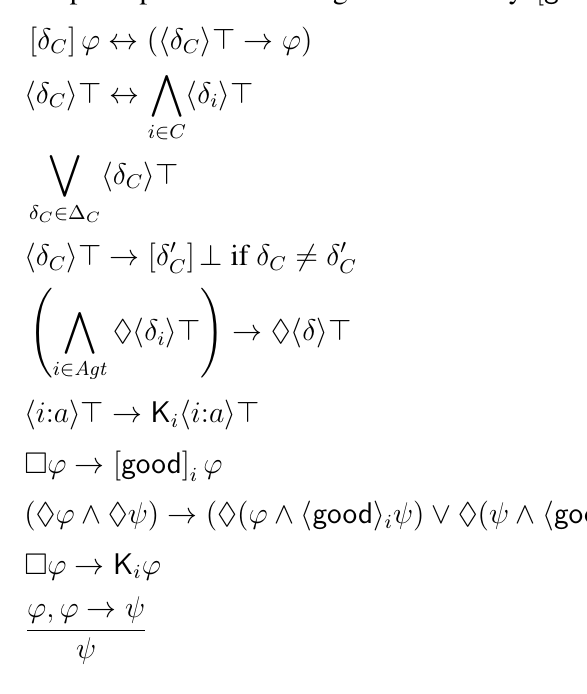
All principles of classical propositional logic( CPL ) All principles of modal logic S5 for (cid:3) ( S5 (cid:3) ) All principles of modal logic S5 for every K All principles of modal logic S4 for every [ good ]